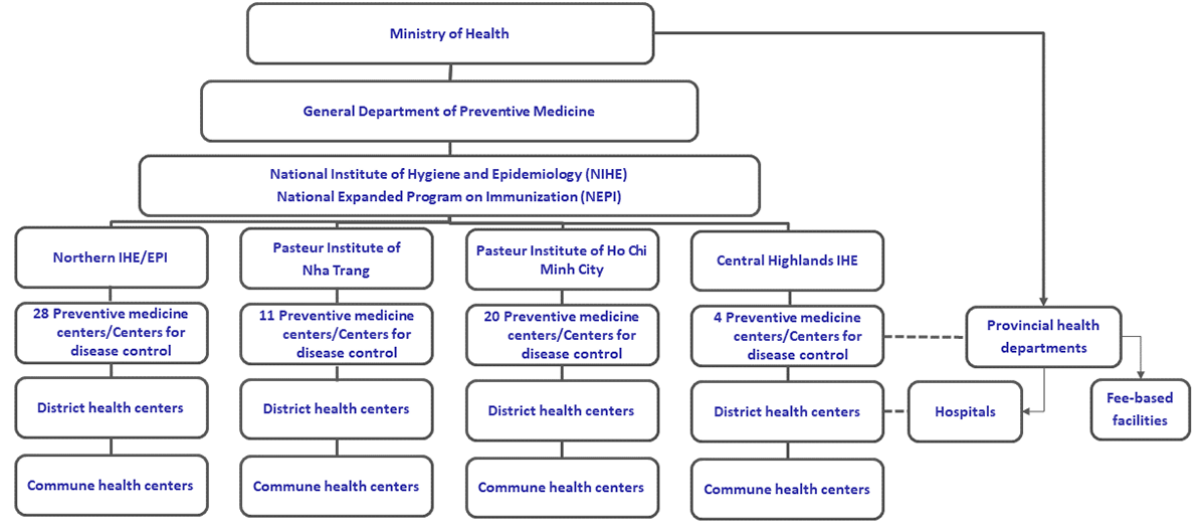
Figure 3. Structure of the health system in Vietnam. EPI: Expanded Program on Immunization; IHE: Institute of Hygiene and Epidemiology.